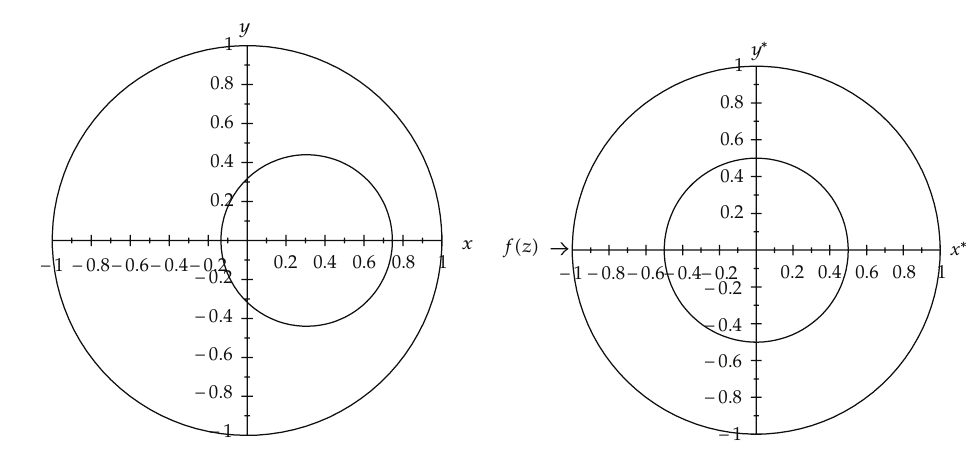
Figure 1: The M¨obius